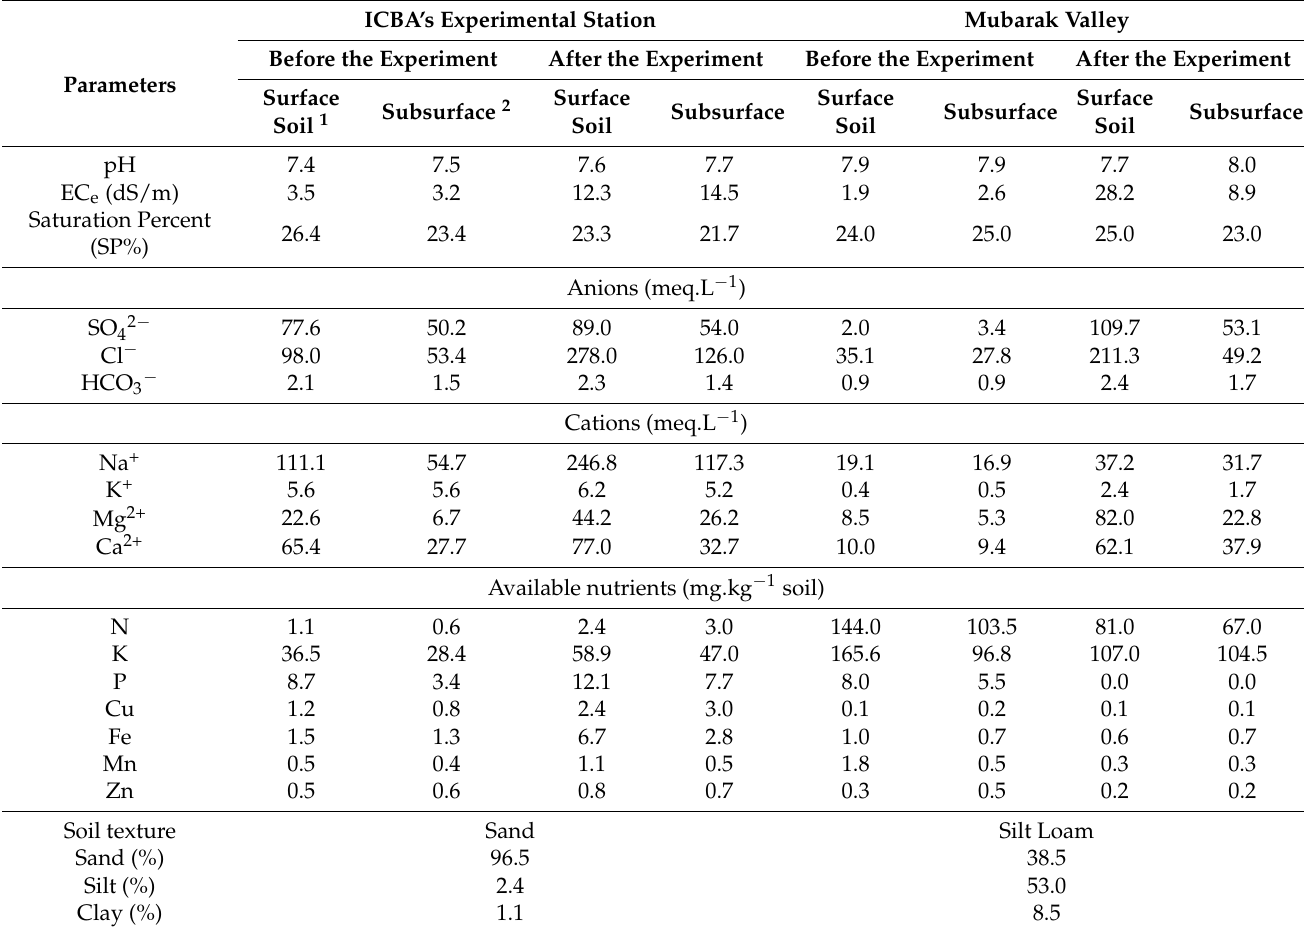
Table 5. Soil analysis of the experimental plots where S. bigelovii was cultivated at ICBA and Mubarak Valley. ICBA’s Experimental Station After the Experiment Before the Experiment After the